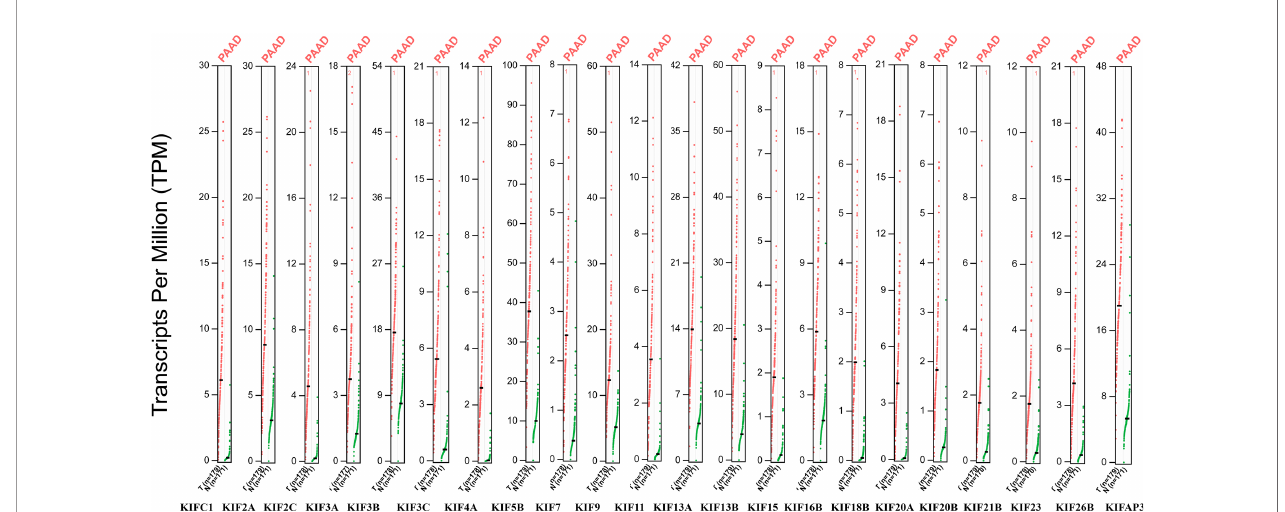
FIGURE 1 | The expression of KIFs in PDAC (GEPIA). Dot plots pro fi ling gene expression between cancer samples (red dots) and paired normal samples (green dots), with each dot representing a distinct tumor or non-cancerous samples. Each column represents a gene. The genes that are differential expression in cancer tissues compared to normal tissues were presented above ( p < 0.05). The TPM value is used to display the relative expression of